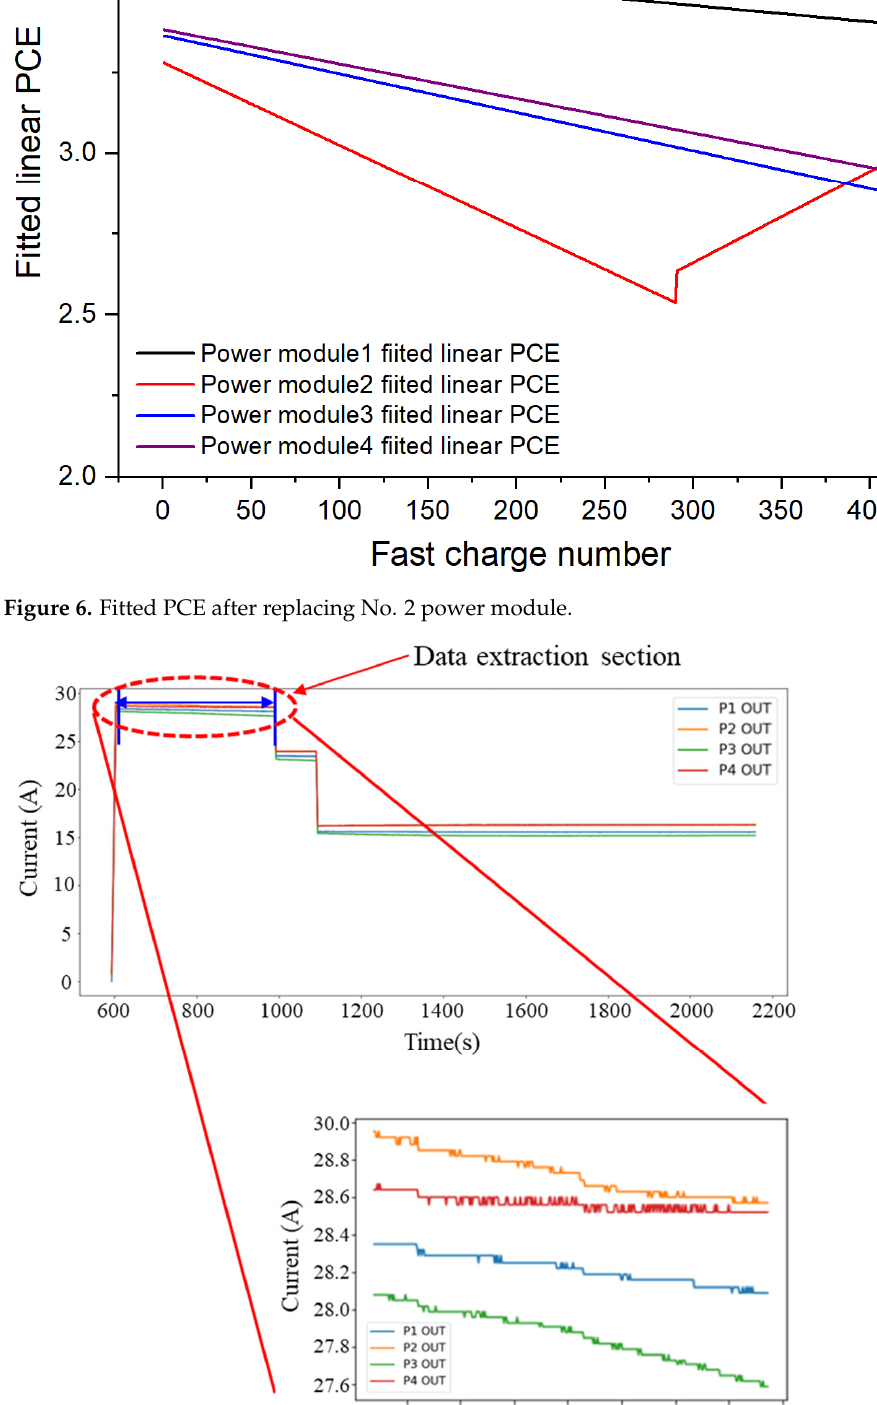
Table 3. Feature data calculation method using analysis section data.